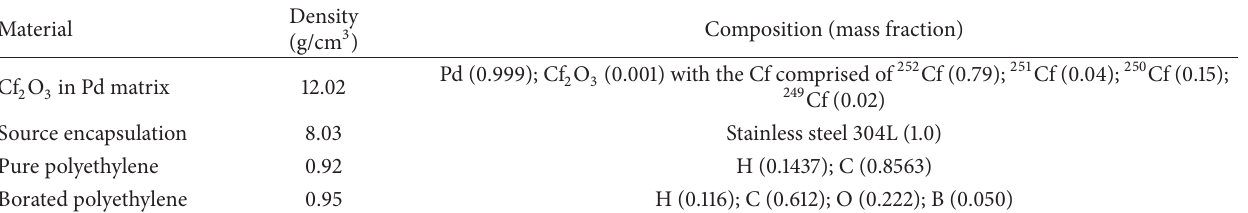
Table 5: Properties of select irradiator